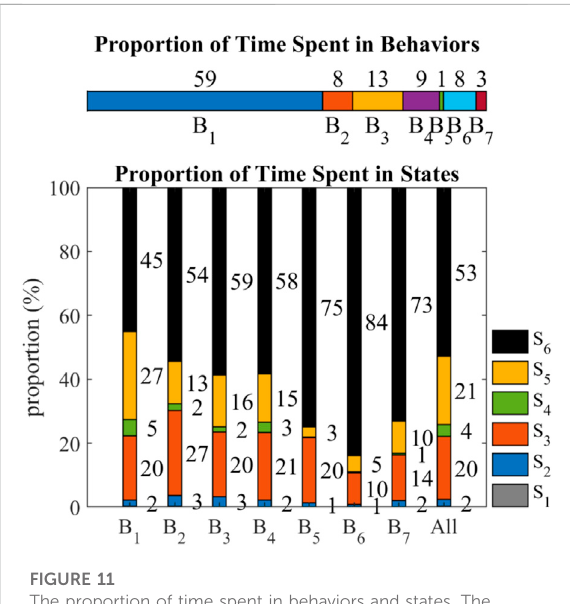
FIGURE 11 The proportion of time spent in behaviors and states. The values near the stacked bars indicate the proportion of time in percentage, and values less than 1% are hidden in this